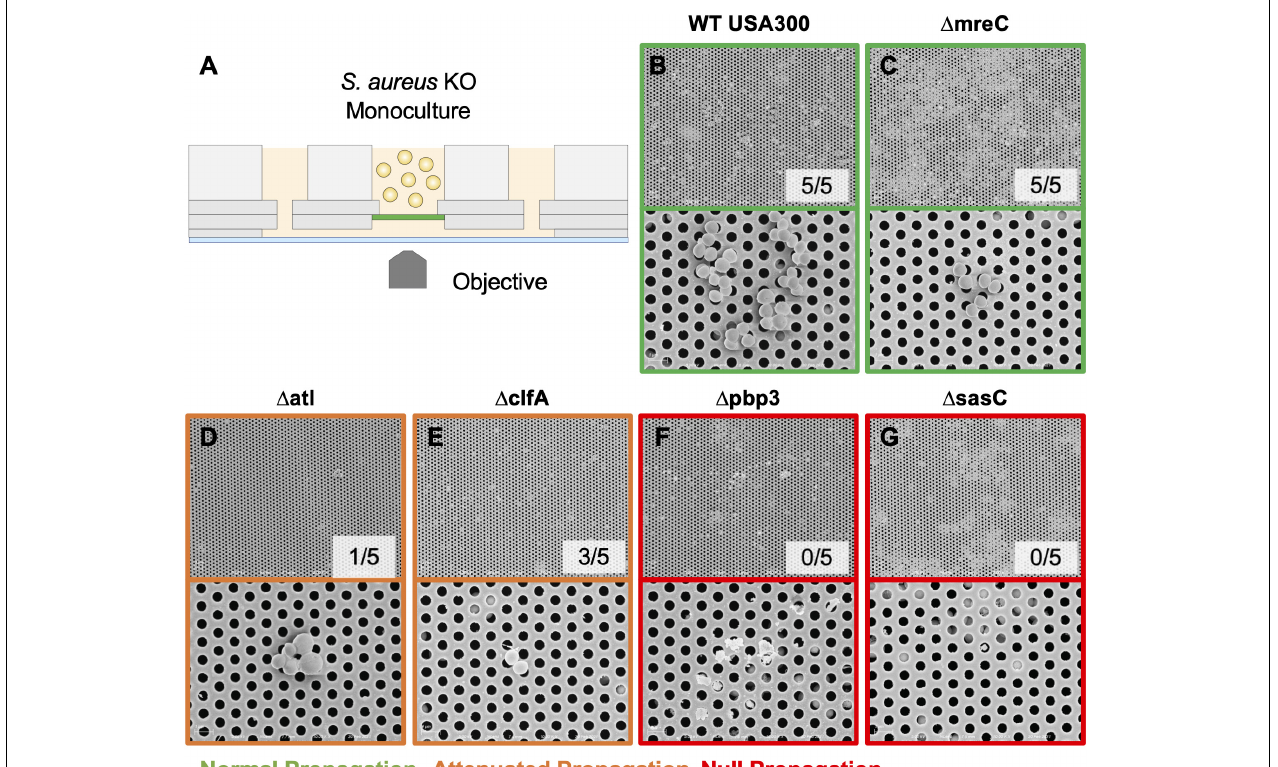
FIGURE 4 | Evaluating S. aureus deletion mutant deformation and propagation through 0.5- µ m pores in the microfluidic silicon membrane-canalicular array ( µ SiM-CA). Pure cultures of WT USA300, (cid:49) pbp3, (cid:49) atl, (cid:49) mreC, (cid:49) clfA, and (cid:49) sasC were assayed for their ability to propagate through the 0.5- µ m pores of the µ SiM-CA device ( n = 7 independent experiments) and processed for SEM imaging of the bottom surface of the membrane ( n = 3 devices imaged per group). Experimental design is illustrated in panel (A) . Representative SEM images are shown at 5,000 × (top panel) and 15,000 × (bottom panel) for each genotype (B–G) , and the fraction of successful propagation to the bottom is indicated. As shown in previous work, WT bacteria readily propagated through the 0.5- µ m pores following 6 h of incubation (B) . S. aureus lacking mreC expression showed no difference from WT (C) . Atl and clfA deletion resulted in “attenuated propagation,” characterized by very few bacterial cells present on the bottom surface of the membrane (D,E) . Finally, pbp3 and sasC deletion mutants displayed “null propagation” with zero bacterial cells cultured in the bottom channel or visualized on the bottom surface of the membrane (F,G) . Only cellular and media debris were found on the bottom surface of membranes from (cid:49) pbp3 studies (F) .